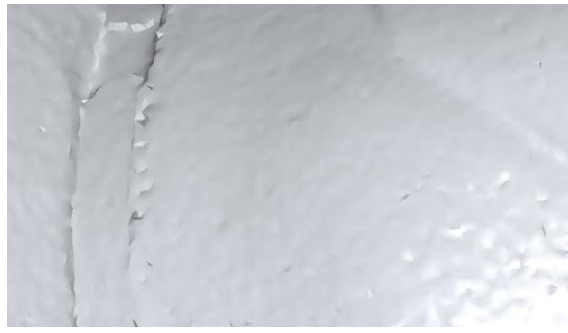
Figure 15 - Detail of the TLS model of a bowl-shaped vault